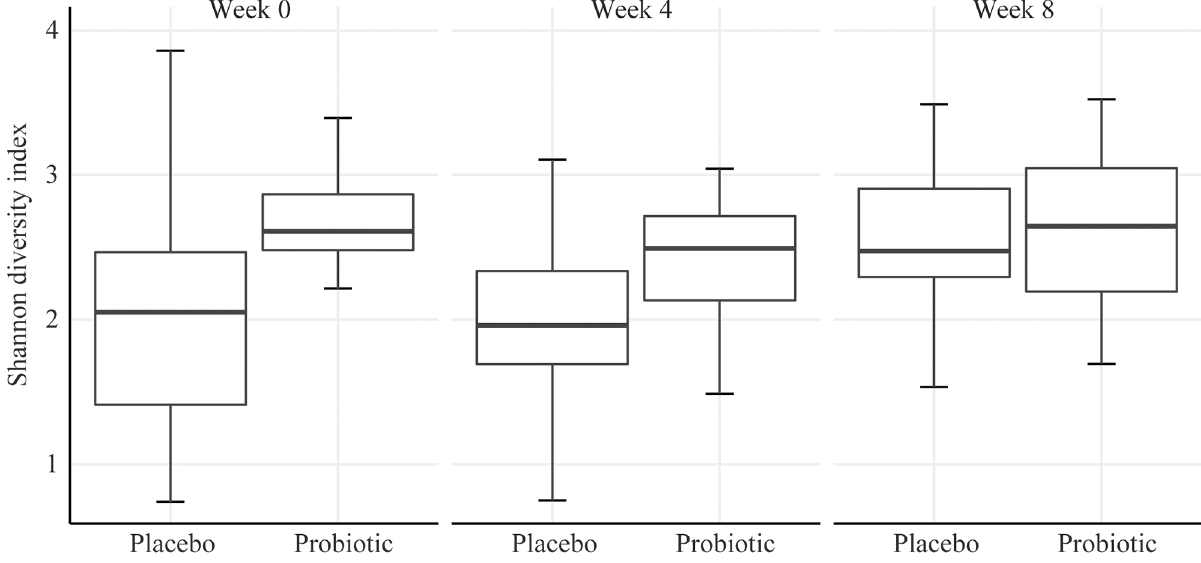
Fig 1. Microbial α -diversity as measured by the Shannon diversity index. The Shannon diversity index, which is a heterogeneity measure that combines richness and evenness components of microbial diversity does not significantly differ when subjects take probiotics.